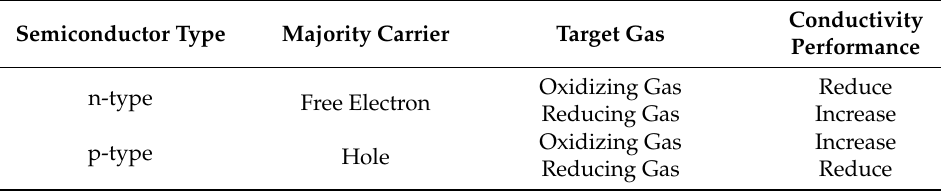
Table 2. The conductivity of different MOSs in different gas conditions. Semiconductor